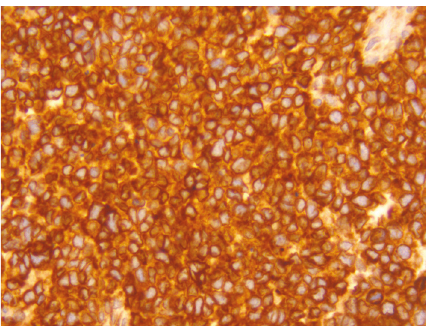
Figure 13: Immunohistochemistry shows positive cytoplasmic staining of the tumor cells for bcl-2